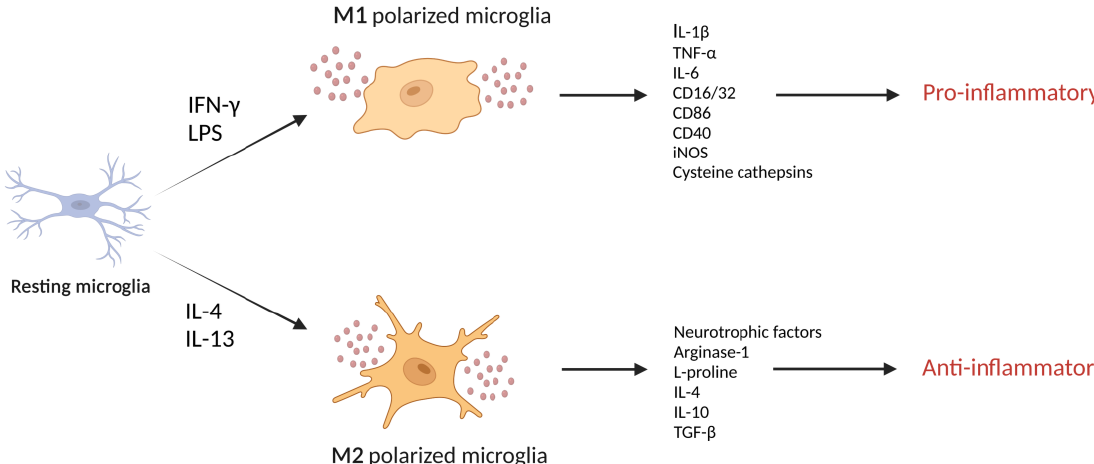
Figure 1. Scheme of M1-like or M2-like polarization of microglia. Microglia polarize the M1-like state (classic, proinflam- matory) following stimulation of lipopolysaccharide (LPS) or interferon (IFN)- γ , whereas microglia polarize M2-like state (alternative, anti-inflammatory, protective) by protective cytokines such as interleukin (IL)-4 or IL-13. The M1-like responses are shown by the upregulation of pro-inflammatory cytokines such as interleukin IL-1 β , IL-6, tumor necrosis factor (TNF)- α , cluster of differentiation (CD)16/32, CD86, CD40, inducible nitric oxide synthase (iNOS), and cysteine cathepsins. The M2-like responses are shown by the upregulation of markers such as arginase-1, L-proline and anti-inflammatory cytokines, IL-4, IL-10 and transforming growth factor (TGF)- β, and neurotrophic factors.